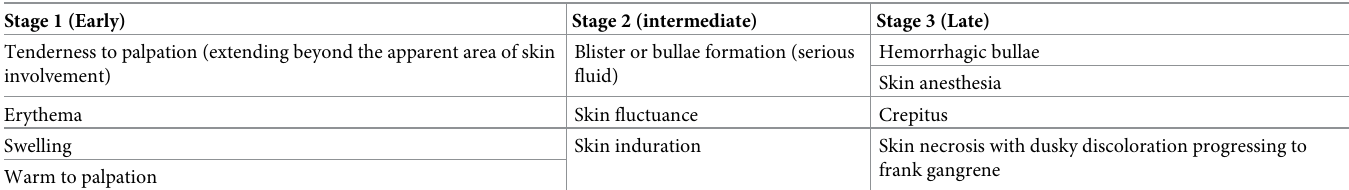
Table 2. Clinical features of NF as the disease progress through clinical